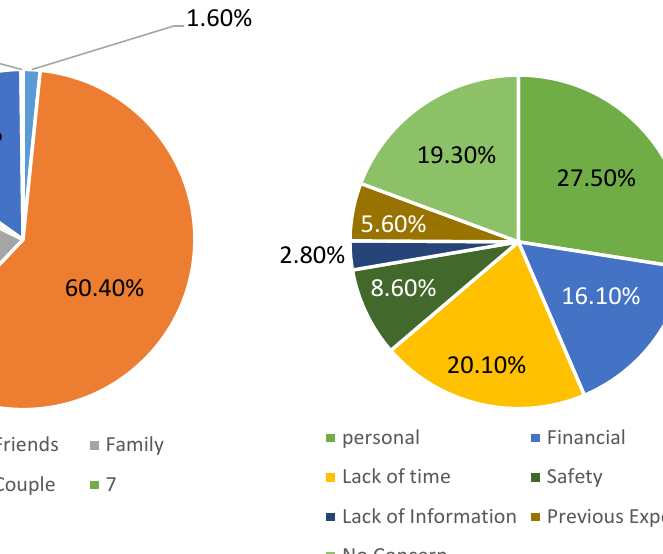
Figure 4. Individual cost vs group cost